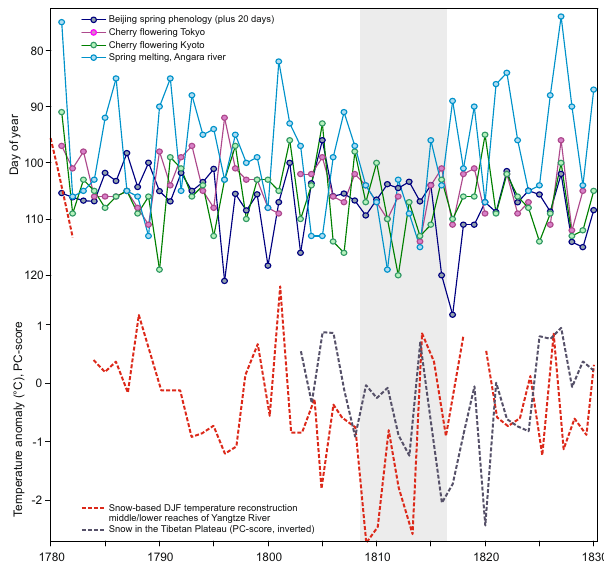
Fig. 5 Day-of-year (note the reverse scale) of spring phenological dates from East Asia (Table S1) as well as a winter temperature reconstruction based on documentary snow data and a snow proxy from Tibet (lower scale). Note that none of these six series was used in BRW CCC , BRW NCAR , and BRW EKF . The grey shading indicates the period of